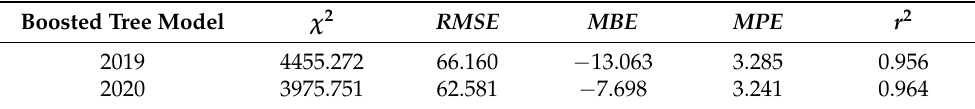
Table 3. The “goodness of fit” tests for the developed BRT model. Boosted Tree Model